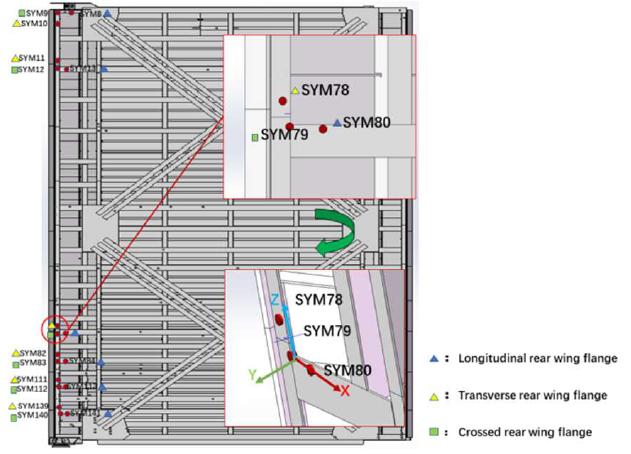
Figure 7. Schematic diagram of the strain sensor layout on the gate pivot axis of the gate. Each group of three sensors was installed at the longitudinal, transverse, and con- nection points of the rear flange plate, and the stress sensors near the gate shaft column and on the first to the 27th layer on the rear flange plate were selected for analysis. In this paper, the stress signals were extracted from when the miter gate finished closing, filling, draining, and opening during the navigation upstream of the ship on 3 May 2022. Since the operation of the miter gate constantly repeats the action within the above period, this is called the miter gate navigation cycle. The stress signal waveform of the SYM78, SYM79, and SYM80 sensors during this navigation cycle is shown in Figure 8.